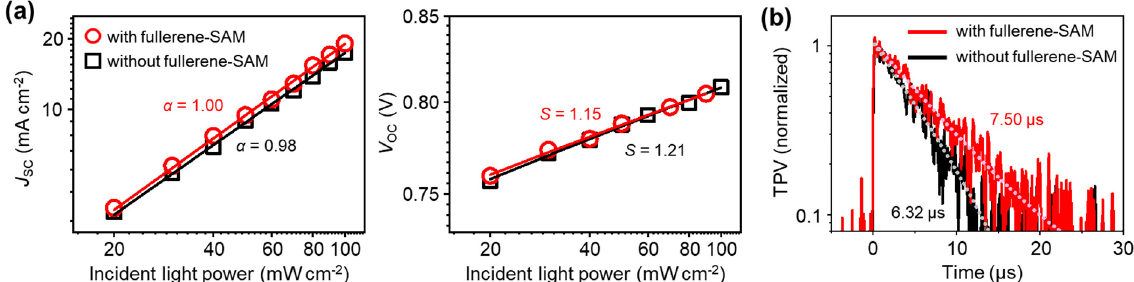
Figure 5. Characterization of charge recombination within solar cells. ( a ) Light power dependence of J SC (left panel) and V OC (right panel). Symbols: measured data points. Solid lines: lines fitted to equations given in the text. ( b ) TPV decay profiles. Solid lines: measured data points. Dotted lines: fitted lines (mono-exponential decay).